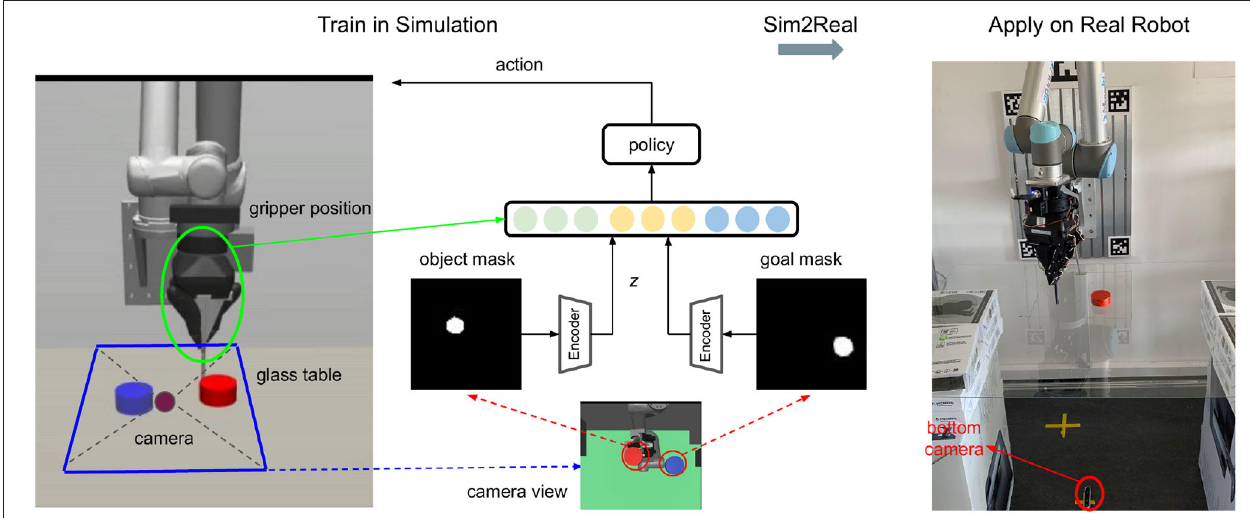
FIGURE 3 | Overview: The training process in simulation is shown on the left, and the model is transferred directly to the real platform (on the right side). The camera is put below the transparent table to avoid possible occlusions between the camera view and the object during manipulation. Color filtering is applied to the image from the bottom camera to obtain both the object (red) and goal (blue) masks. The two masks are fed into the pre-trained autoencoder and then concatenated with the gripper position into a fusion space, where the policy does